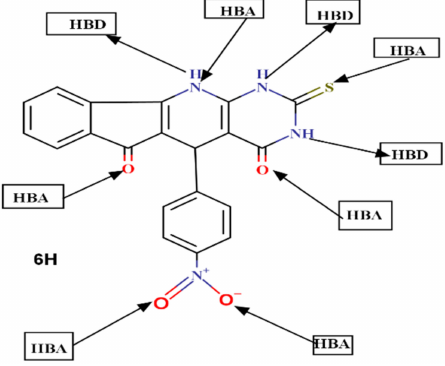
Figure 10. Donor and acceptor sites of compound